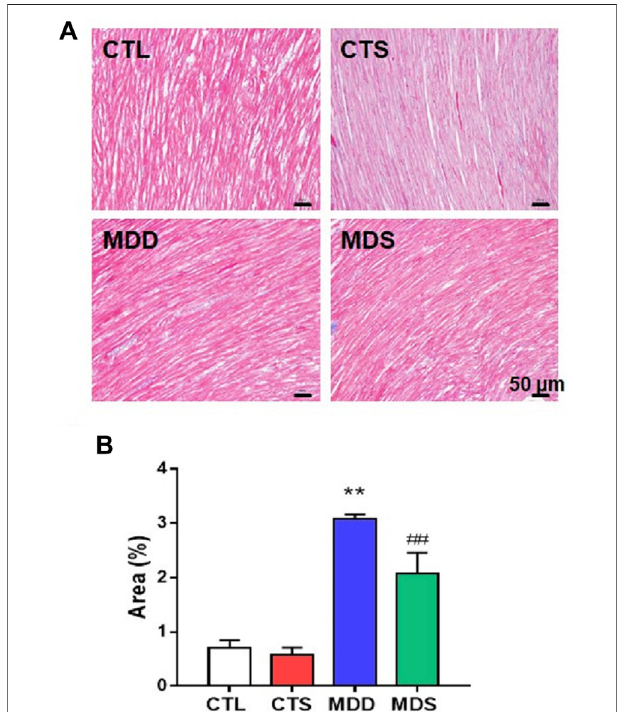
FIGURE 6 | Atrial myocardial fi brosis. (A) Atrium slices stained with Masson stain (original magni fi cation: ×200). (B) Quanti fi cation of the fi brotic area in each group ( n = 5). ** p < 0.01 vs. CTL group; ## p < 0.01 vs. MDD group.